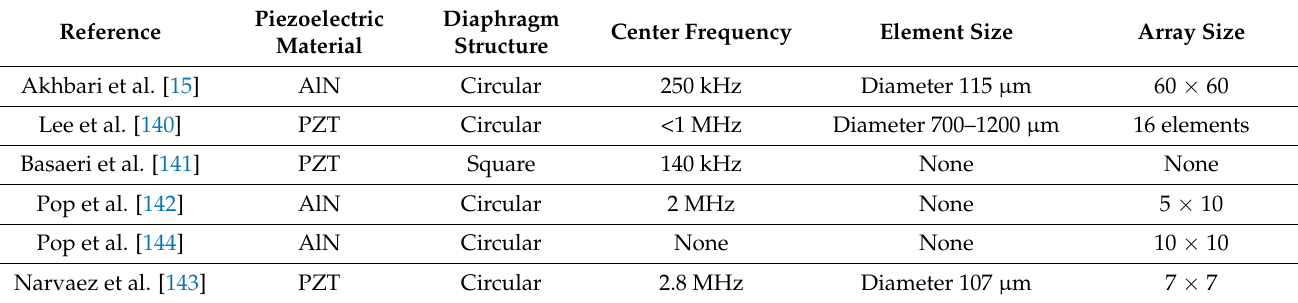
Table 6. Summary of studies of PMUTs for therapeutic